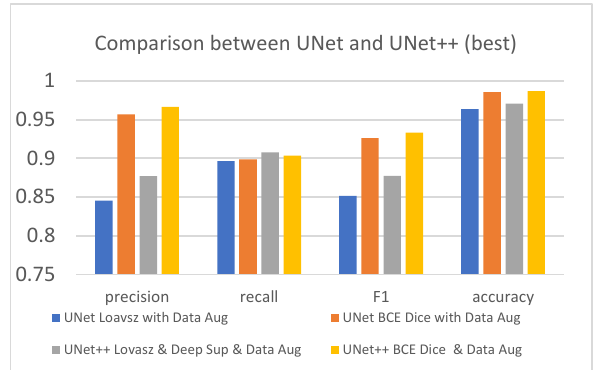
Figure 8: Comparison of the best results achieved with each architecture and each loss